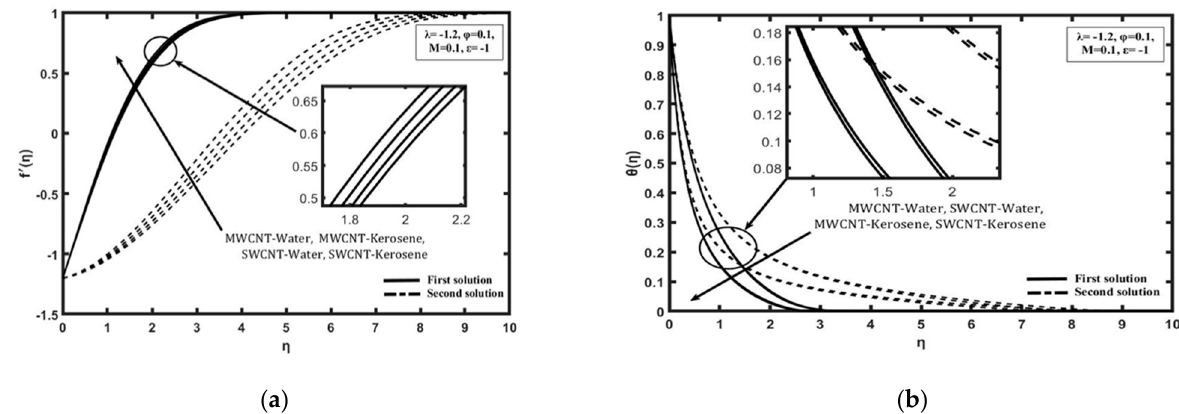
Figure 7. Various CNT and based fluid when M = 0.1, λ = − 1.2, ϕ = 0.1, and ε = − 1: ( a ) Velocity profile; ( b ) Temperature profile.